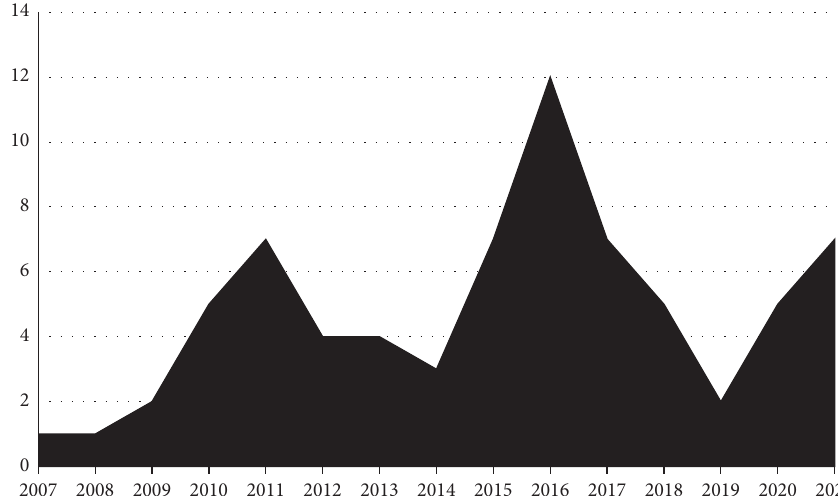
Figure 4: The count of publications by